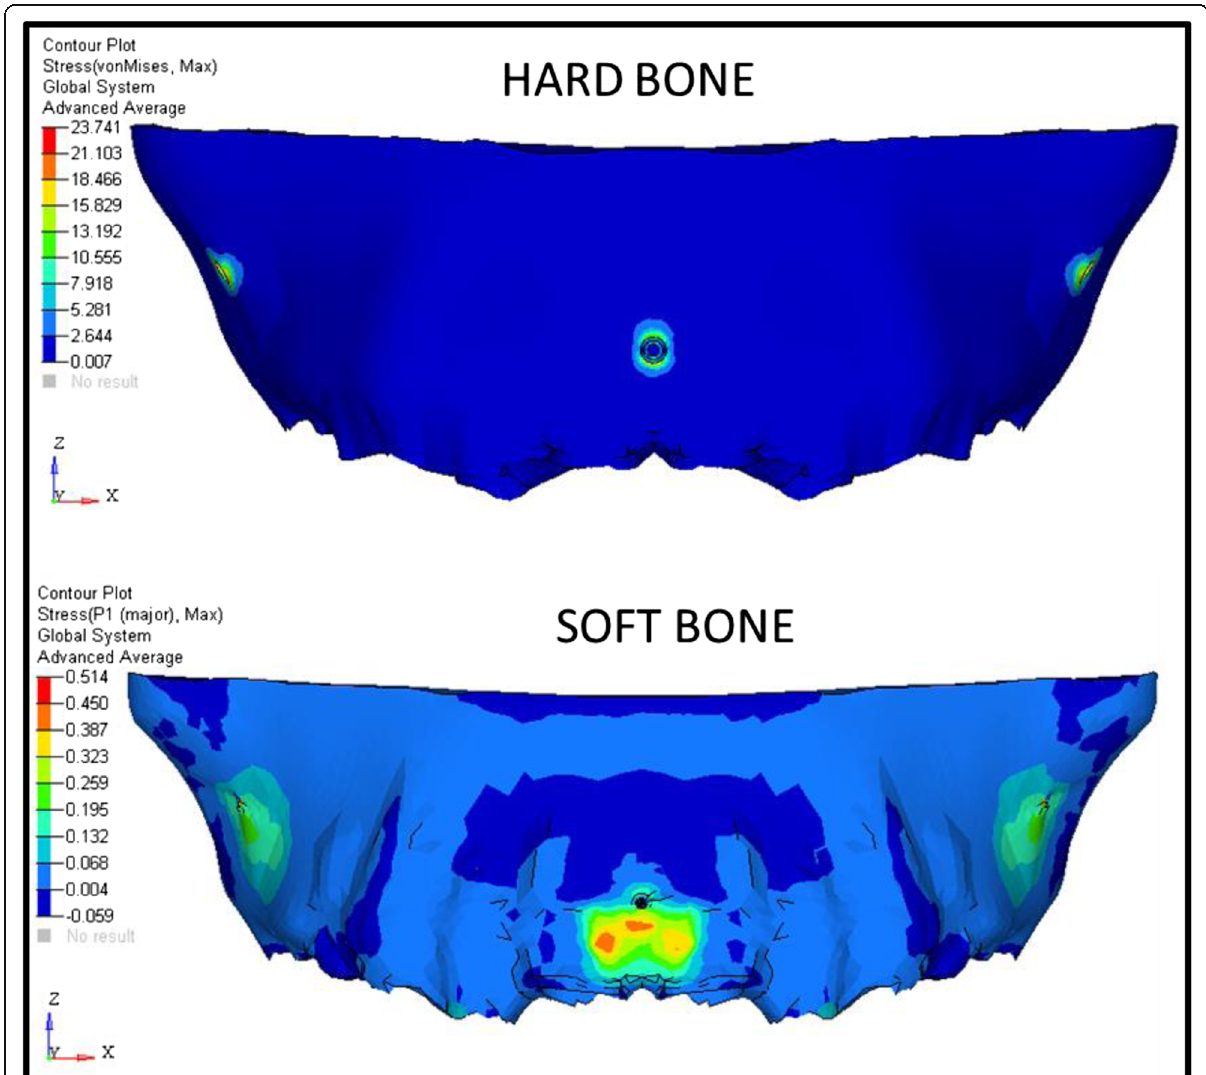
Fig. 7 Stress distribution patterns in the hard bone and soft